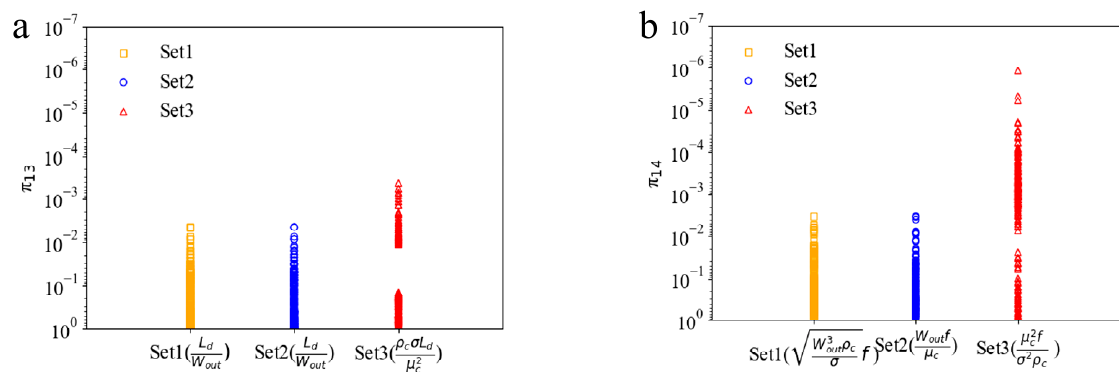
Figure 5. Value ranges of π 13 and π 14 for three sets with slug and dripping patterns in Experiment 1: ( a ) π 13 , ( b ) π 14 .